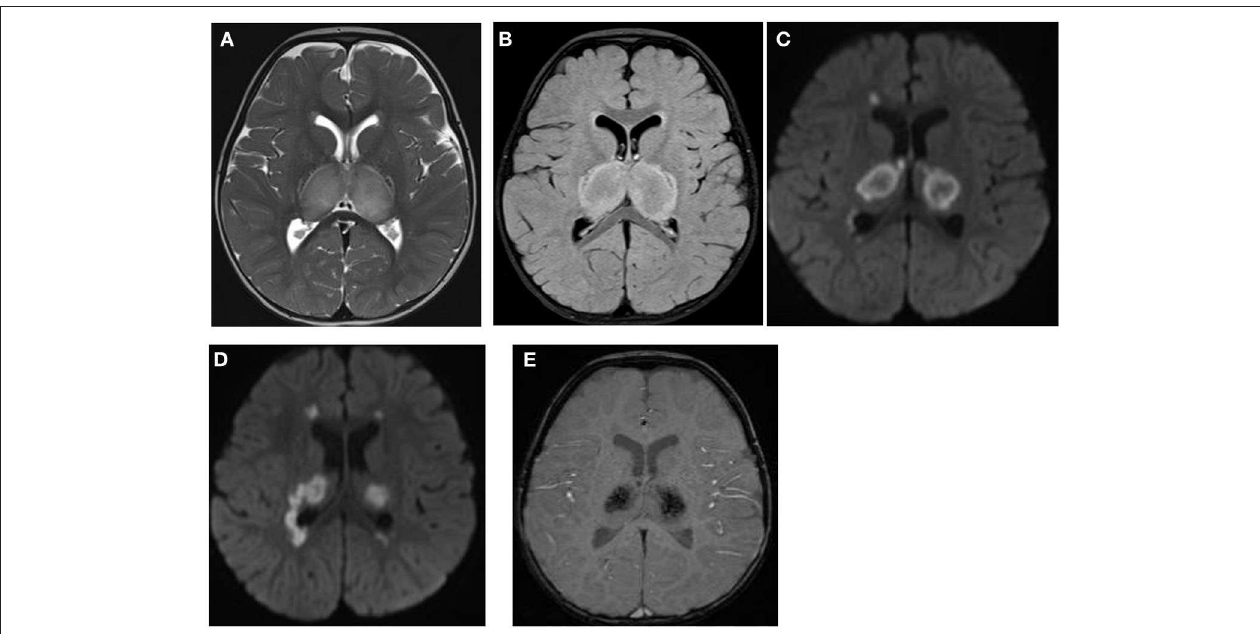
FIGURE 1 | Brain MRI. Axial T2 (A) , FLAIR (B) , diffusion (C,D) , and susceptibility (E) weighted images. There are swelling and abnormal high signal intensity of both thalami (A,B) with diffusion restriction (C,D) and dark signal intensity with blooming (E)